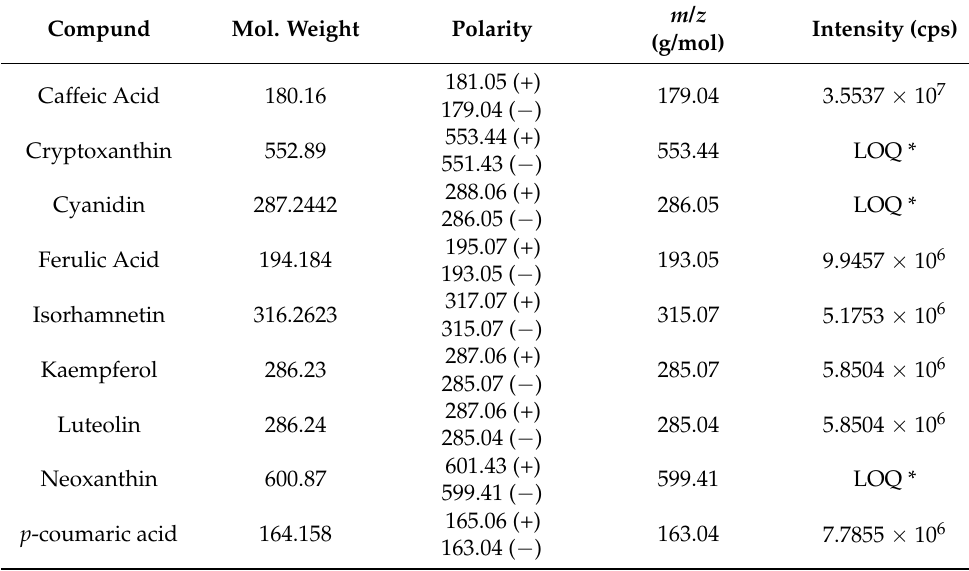
Table 2. List of polyphenols and carotenoids compounds detected in Brassica raimondoi leaf extract by UPLC-MS/MS analysis. Limit of detection (LOD) calculated: 568.2 cps (count per second). Limit of quantitation (LOQ) calculated: 1894 cps (count per